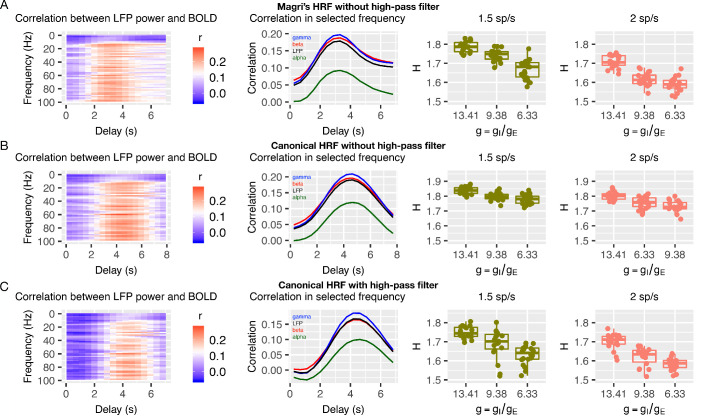
Simulated BOLD with and without high-pass filter and changes to the HRF.Panel A shows a situation where the simulation of BOLD from LFP utilizes the HRF from Magri et al., 2012 but does not incorporate use of the high-pass filter. Panels B shows BOLD simulated from LFP with the canonical HRF without (B) and with (C) the high-pass filter. In the far left column are time-lagged correlations between LFP power over a range of frequencies as a function of the time-delay. The middle column shows LFP power correlations with BOLD in selected frequency bands. The far right column shows plots for how g is related to H in BOLD for each situation.